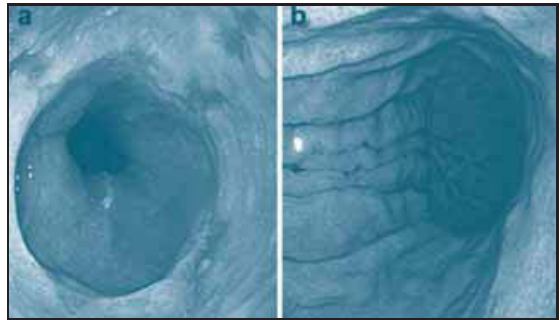
Figure 2. Endoscopic (cid:3) ndings six weeks after completion of H. pylori eradication (a) gastroesophageal junction showing newly-formed, multiple, linear erosions (b) gastric body showing healed super(cid:3) cial